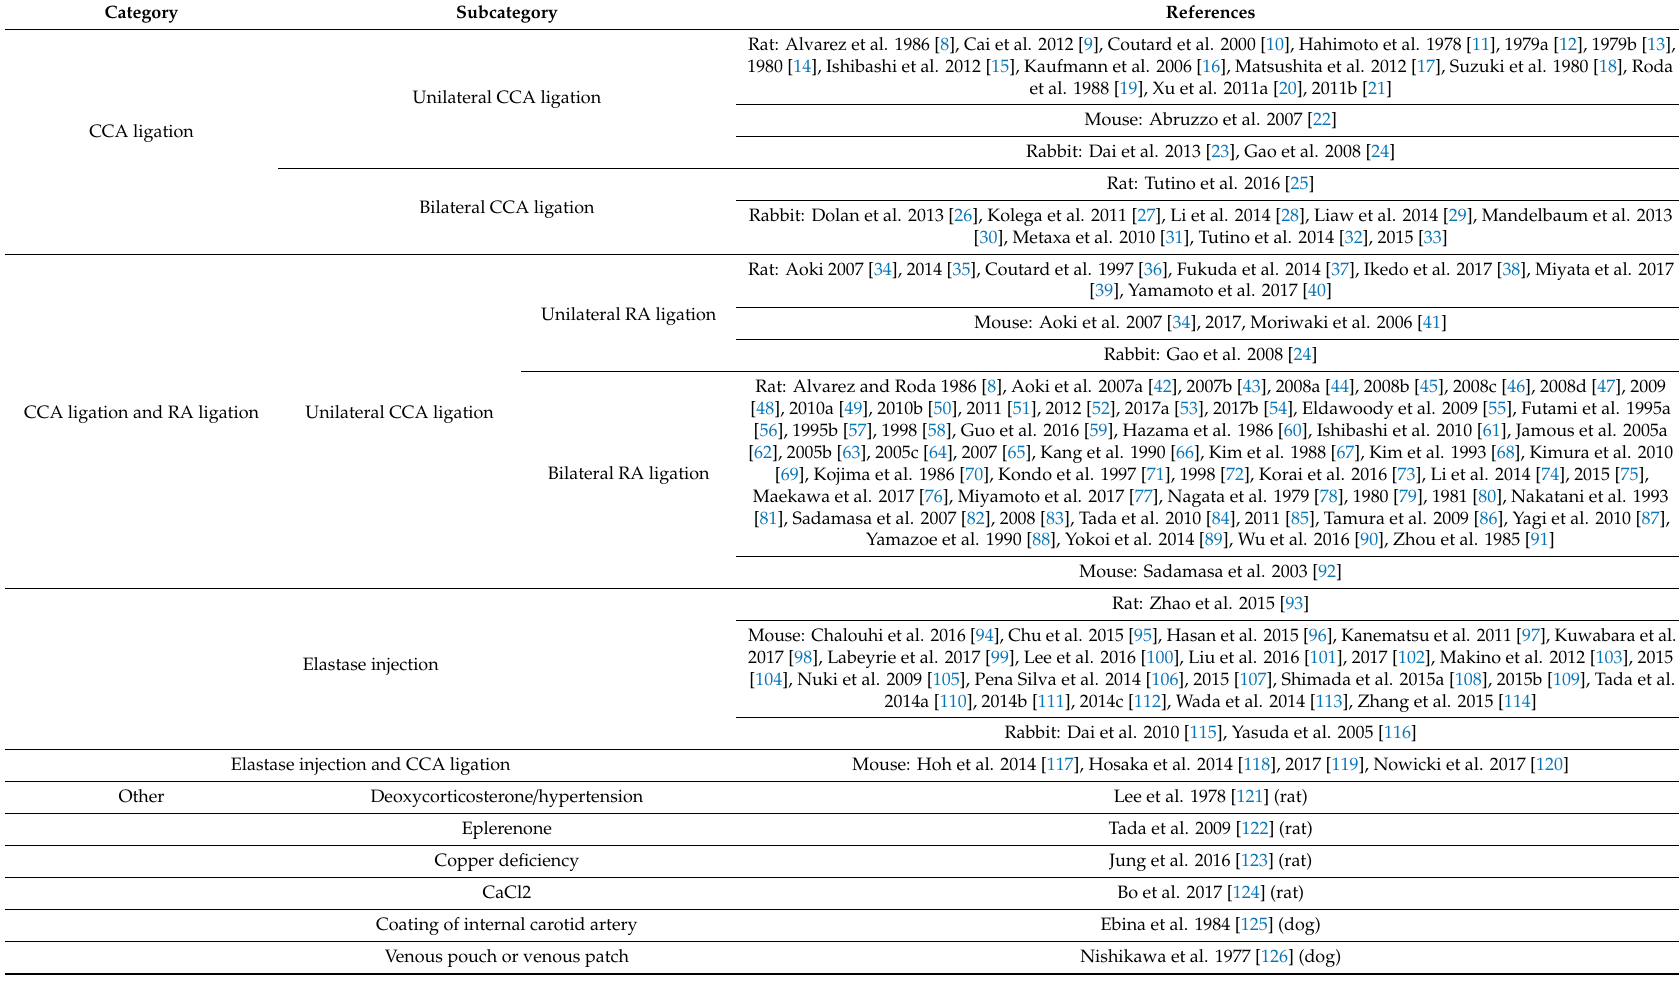
Table 1. Overview of included studies. The most commonly used model in rats was common carotid artery (CCA) ligation and renal artery (RA) ligation, in mice elastase injection, and in rabbits CCA